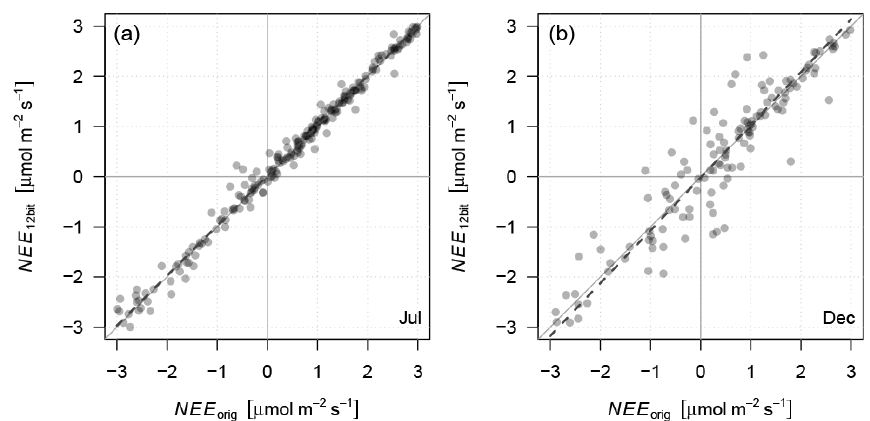
Figure 4. Comparison of the original NEE measurements at Waldstein-Weidenbrunnen site in 2012 (original 16bit digitalization) with calculations using data with 12bit resolution for the gas analyser in summer (July, a , NEE 12 bit = 0 . 995 NEE org , R 2 = 0 . 99, N = 219) and winter (December, b , NEE 12 bit = 1 . 052 NEE org , R 2 = 0 . 87, N = 129). Only data smaller than | 0 . 003mmolm − 2 s − 1 | are shown.